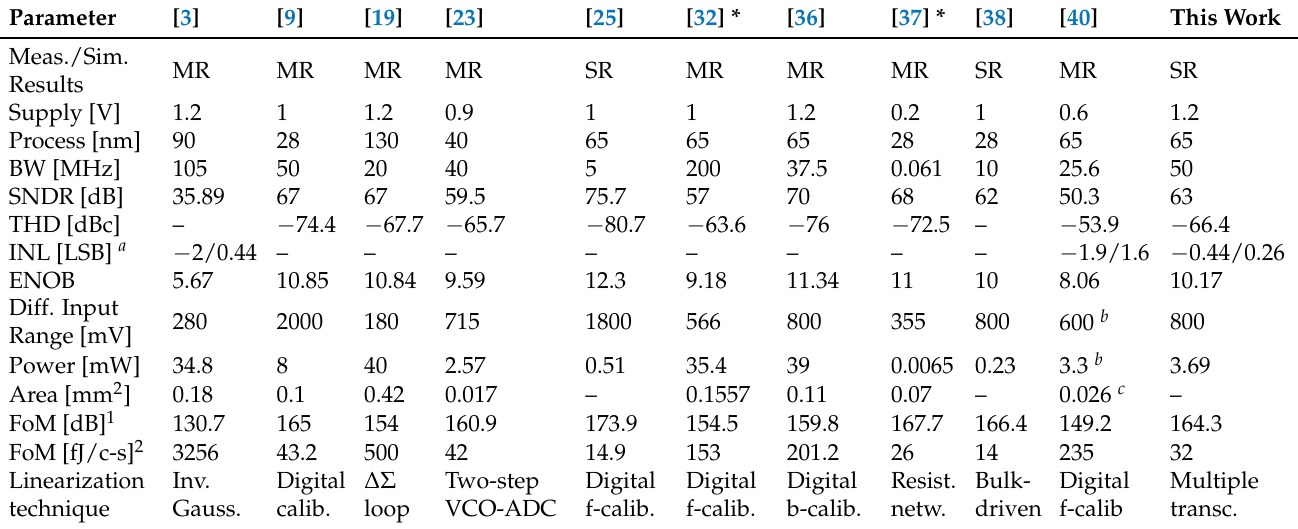
Table 1. Comparison to